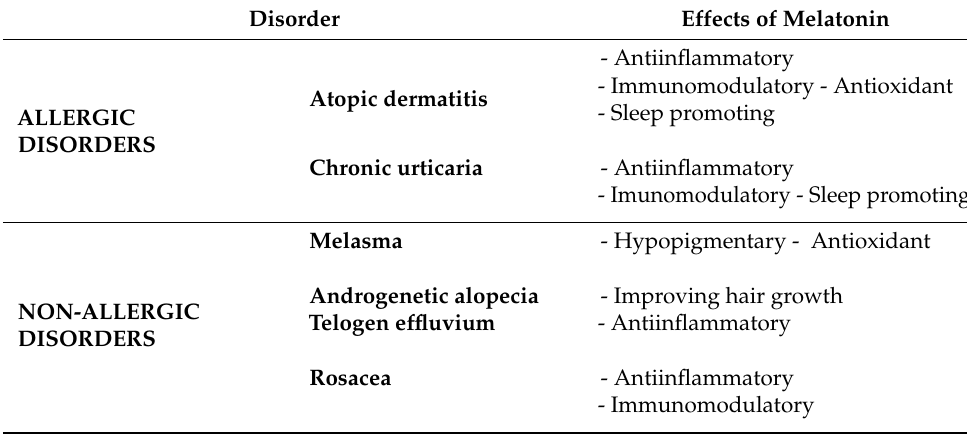
Table 1. Possible effects of melatonin in skin